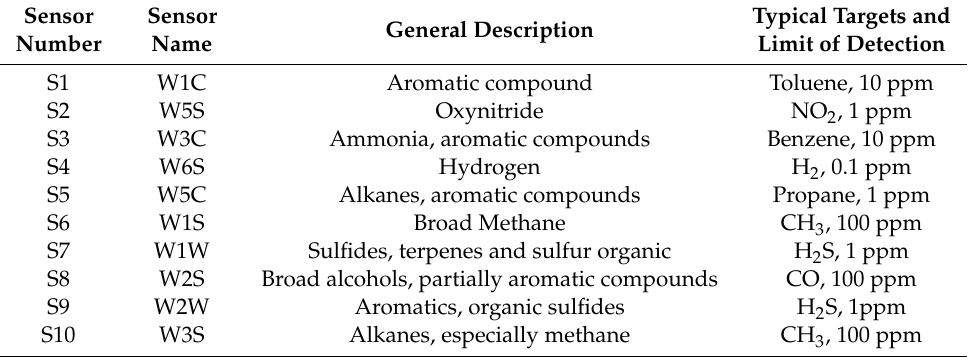
Table 1. Aroma types collected by various sensor arrays of PEN3 electronic